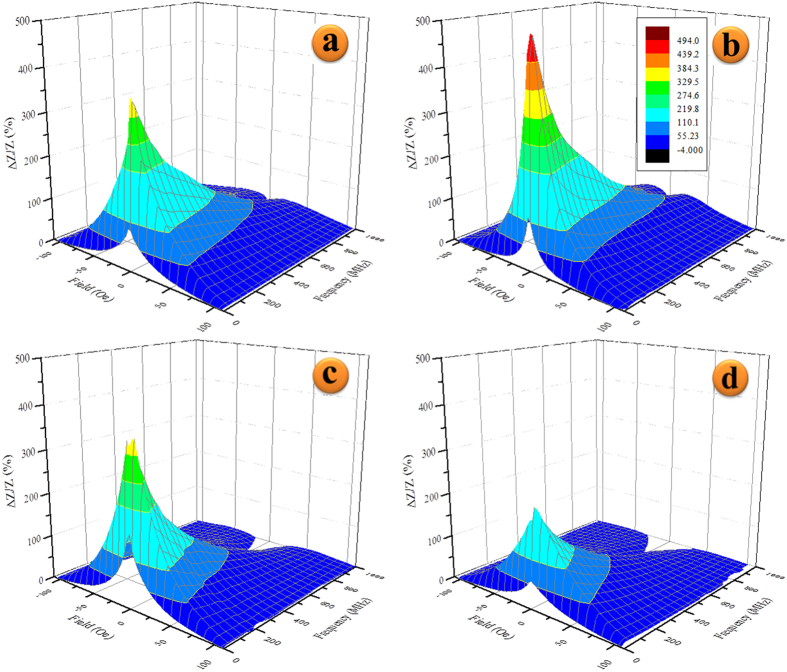
Evolution of the GMI effect in Co68.15Fe4.35Si12.25B15.25-xZrx microwires with (a) x = 0, (b) x = 1, (c) x = 2, and (d) x = 3 as a function of magnetic field and frequency (1–1000 MHz).